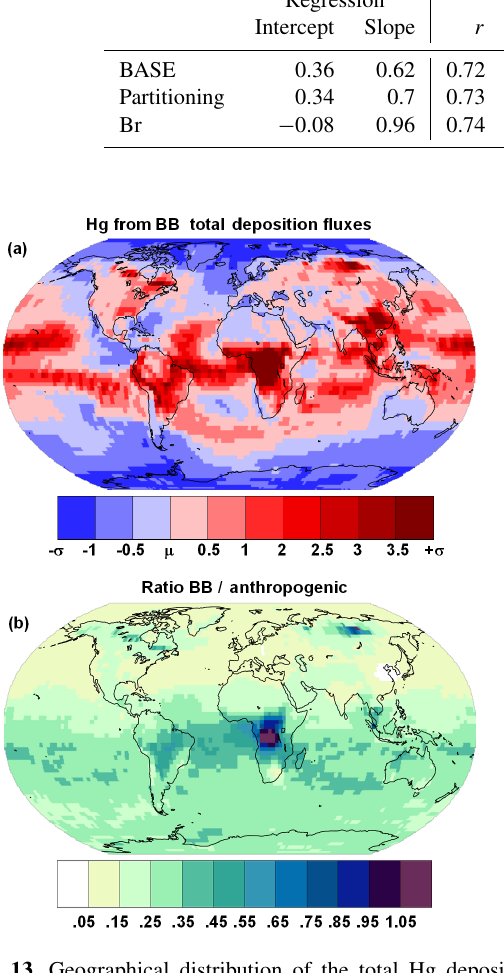
Figure 13. Geographical distribution of the total Hg deposition from BB emissions obtained from an ensemble of simulations for the year 2013 (a) in terms of the average ( µ ) and standard deviation σ of the ensemble. The comparison of the BB simulation with an en- semble of runs including only anthropogenic emissions (De Simone et al., 2016) shows (b) the geographic distribution of the fraction of the BB contribution to the Hg deposition from the anthropogenic sources.